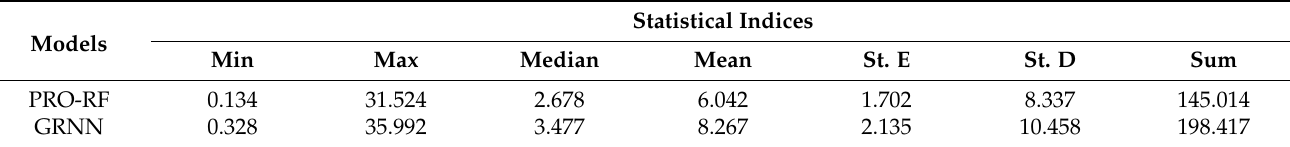
Figure 12. The RD distribution diagrams of the PRO-RF model and the GRNN model.